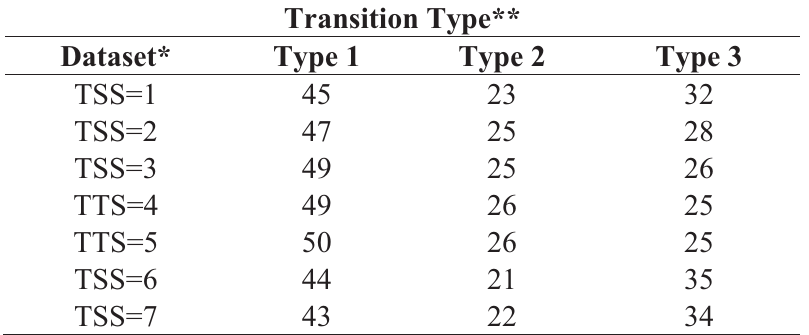
Table S5. Proportion of type 1, type 2 and type 3 transitions in the case of homologous pairs of human Swiss-Prot sequences that differ in one